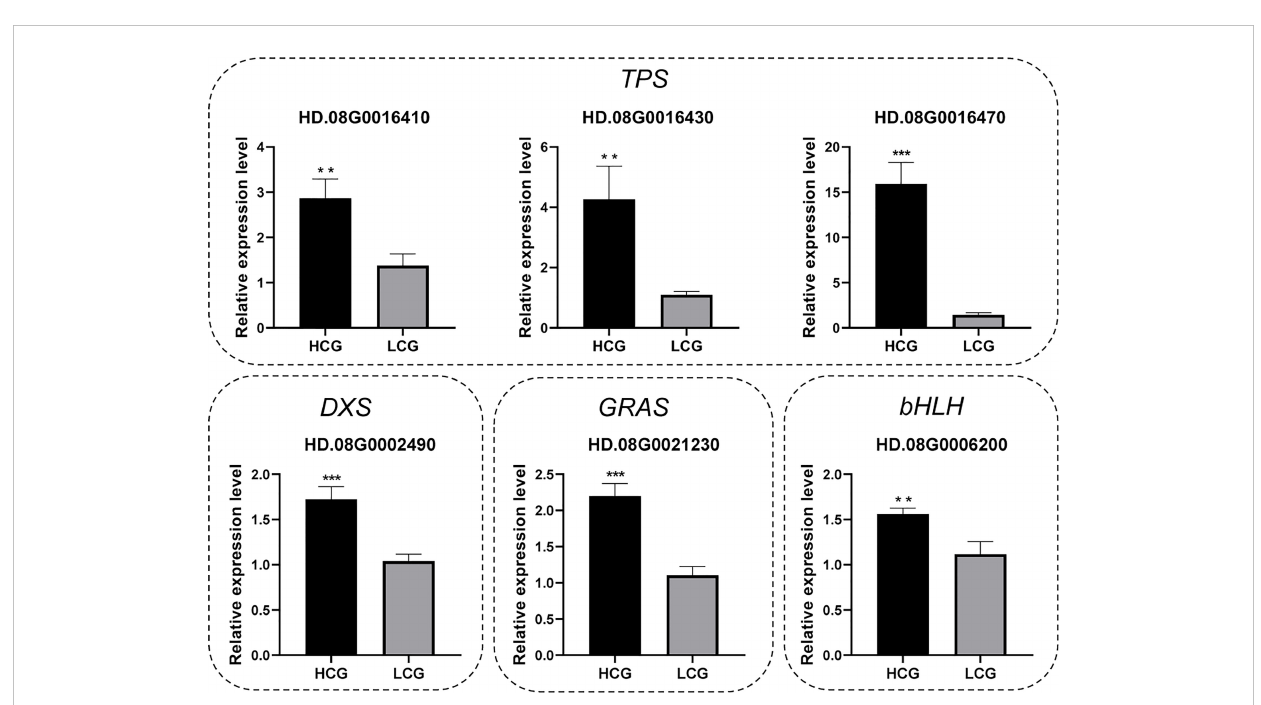
FIGURE 5 Veri fi cation of the candidate gene expression levels by qRT – PCR. Results are expressed as mean ± SEM ( n = 15, ∗∗∗ P < 0.001, ∗∗ P < 0.01). HCG: high-content group, LCG: low-content